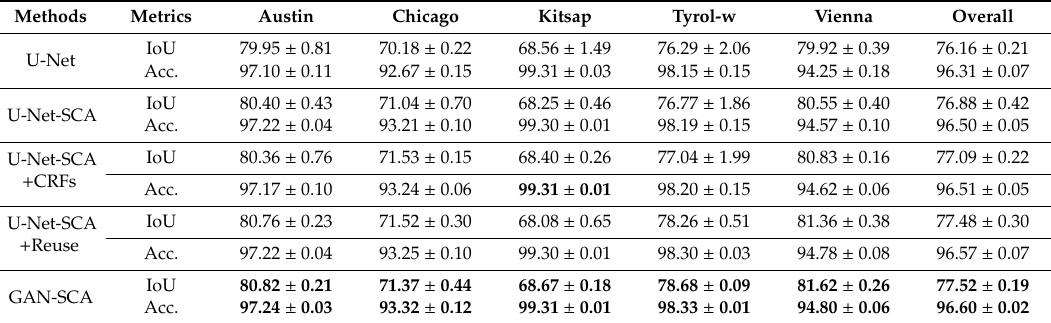
Table 1. Experimental results on Inria aerial image labeling